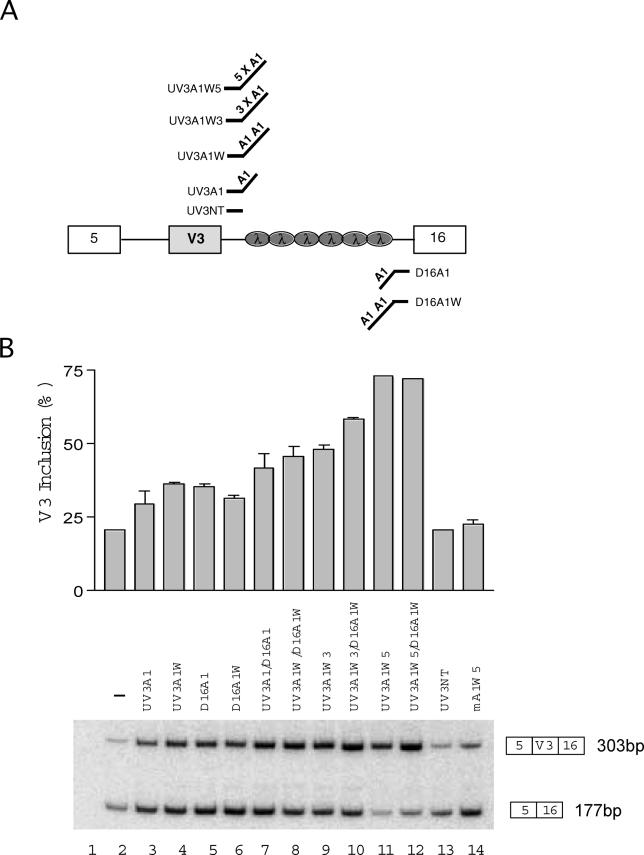
The In Vivo Splicing of a Large Intron Is Improved by ABS-Containing Oligonucleotides(A) Structure of the p44:v3λλλλλλ pre-mRNA. This pre-mRNA contains the alternatively spliced V3 exon as well as constitutive exons 5 and 16 from the CD44 gene. Six 1-kb lambda DNA repeats (gray circles) were inserted downstream of V3 to increase the length of this intron [2]. The position and structure of the RNA oligonucleotides are depicted. A1 indicates an ABS element.(B) COS-7 cells were transfected with plasmid p44:V3λλλλλλ. Twenty-four hours later, they were treated with different 2′O-Me RNA oligonucleotides, and total RNA was extracted after 24 h. A RT-PCR assay was performed in the presence of (32P)dCTP to determine the relative levels of both mRNA splicing products. The inclusion frequency of exon V3 expressed as a percentage is shown graphically with mean value and error bars derived from three separate experiments.